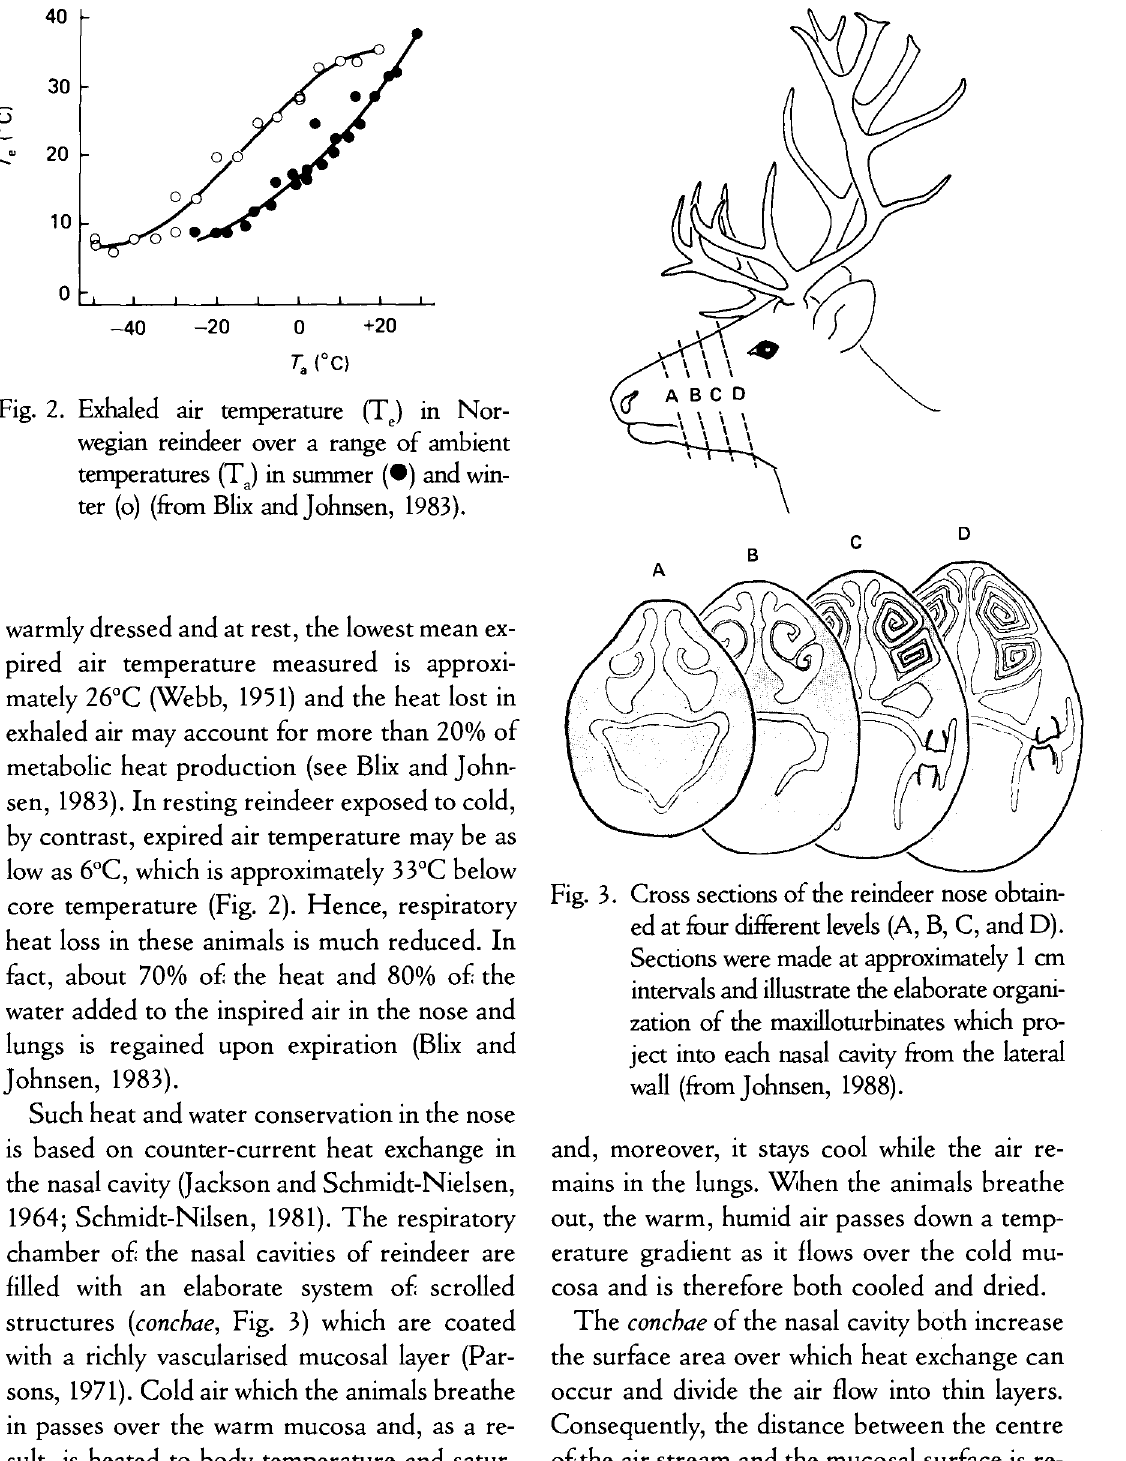
Fig. 2. Exhaled air temperature (T ) in Nor wegian reindeer over a range of ambient ter (o) (from Blix and Johnsen, 1983).